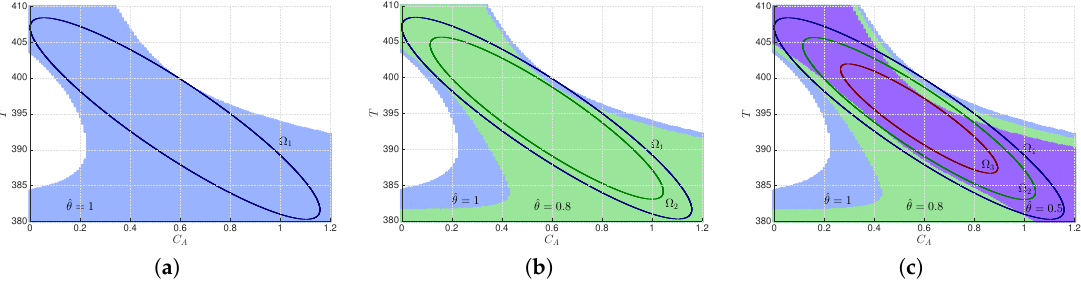
Figure 2. Estimates of the region of guaranteed fault-tolerant stabilization under MPC: ( a ) Ω 1 represents the estimate when (cid:98) θ = 1 (blue level set); ( b ) Ω 2 represents the estimate when (cid:98) θ = 0.8 (green level set); ( c ) Ω 3 represents the estimate when (cid:98) θ = 0.5 (purple level